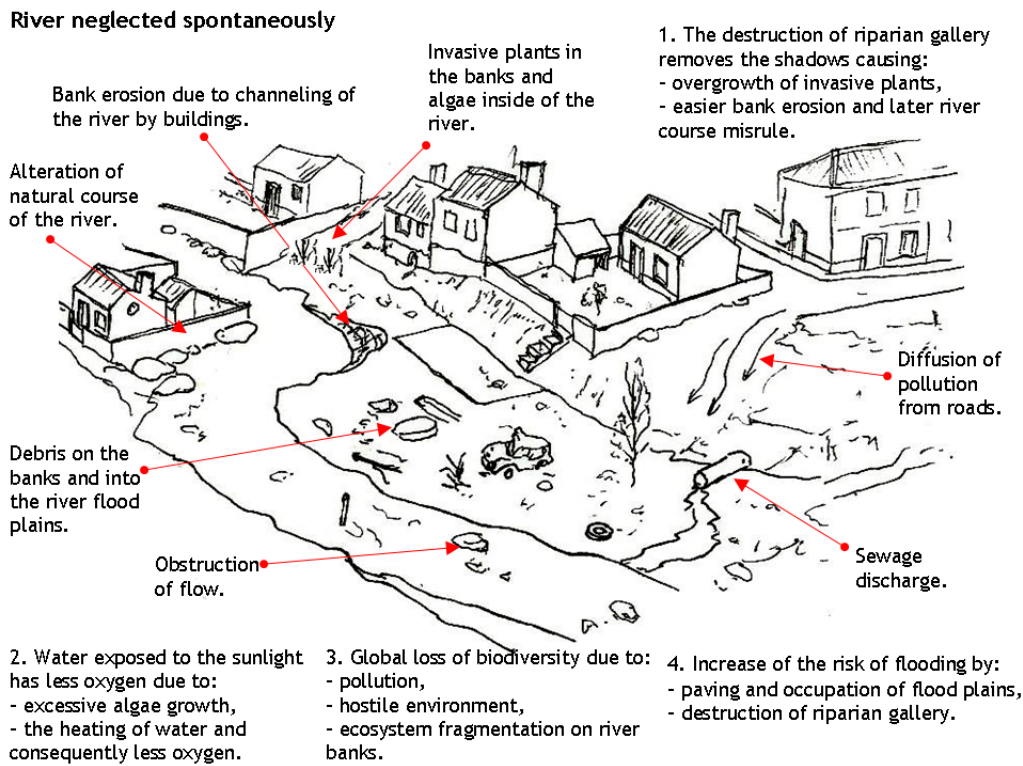
Figure 4a: The picture of the neglected river, where disordered households and its nearby areas are causing the degradation of the natural water line.